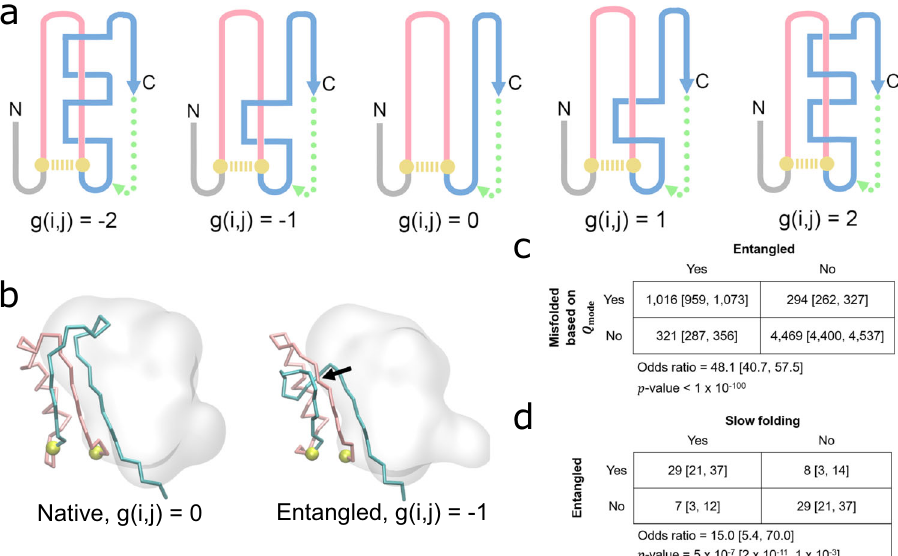
Fig. 3 Detecting non-native entanglements in a monomeric protein structure. a Schematic of how self-entanglements can be detected by examining the change in the Gauss linking number g( i,j ) (Eq. (5)) between a closed loop (pink) formed by the backbone segment between residues i and j that form a native contact (gold dashed line) and another pseudo-closed loop formed by the C-terminal backbone segment (blue) and a pseudo-vector (dashed green line) connecting the C-terminal residue and the start of the C-terminal segment, which begins at residue j + 1. Threading of the N-terminal segment (composed of residues 1 through i − 1) is determined in a similar manner. Examples of different Gauss linking numbers and their corresponding structures are shown in this hypothetical illustration. The magnitude of g( i,j ) is proportional to the number of threading events of the blue segment through the pink loop, while its sign is a function of the relative positioning of primary structure vectors at crossing points between the pink and blue segments. The structure with g( i,j ) = 0 exhibits no entanglement. b An example of a gain in entanglement of the protein YjgH (PDB: 1PF5), where the C-termini (cyan) threads a loop (pink) formed by the native contact between residues D72 & Y104 (gold). The black arrow indicates the location of the crossing point of the two entangled loops. c Contingency table indicating the number of trajectories that are misfolded/folded across our 122 proteins based on Q mode analysis and entangled/not entangled. Indicated p -values and odds ratios were computed in SciPy using the Fisher Exact Test. d Same as ( c ) except contingency table displays the number of proteins that are entangled/not entangled and predicted to be slow folding/fast folding. For the purposes of this analysis, a protein is considered slow- or fast-folding if its computed folding time is above or below the median folding time from the set of 73 proteins with reliable estimates, respectively. A protein is considered entangled if ≥ 50% of its misfolded trajectories are entangled. All error bars are 95% con fi dence intervals computed from bootstrapping 10 6